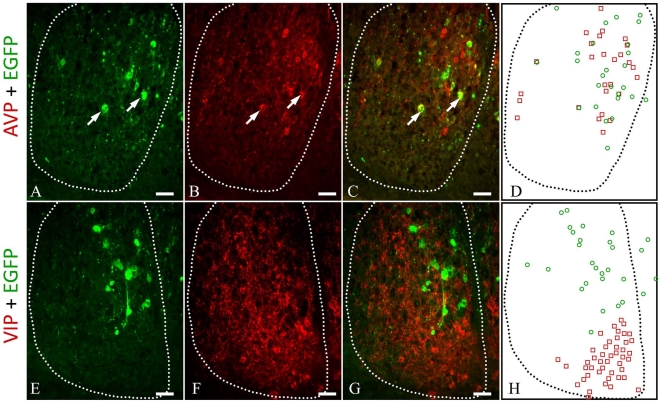
A subset of EGFP-ir cells in the SCN co-expressed vasopressin (AVP).A–C. Double immunostaining against EGFP and AVP in the SCN. Cells that were positive for both EGFP and AVP signals were marked by arrows. D. The localizations of EGFP- and AVP-positive neurons in the SCN were shown schematically. E–G. Double immunostaining of EGFP and vasoactive intestinal peptide (VIP) in the SCN. No neuron was positive for both EGFP and VIP signals. H. The localizations of EGFP- and VIP-positive neurons in the SCN were shown schematically. In all images, the boundary of SCN was indicated by the dotted line. The third ventricle was to the right in all images. The animals were sacrificed at ZT9. Scale bar  =  20 µm.